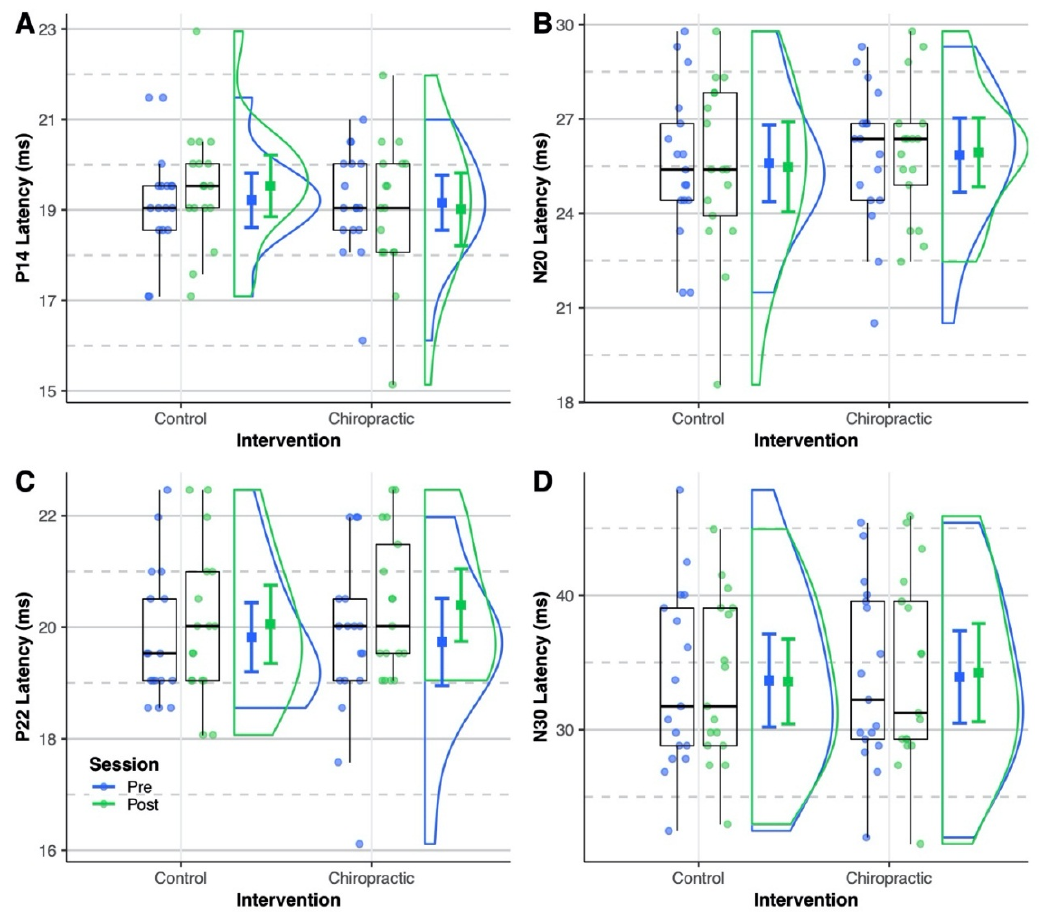
Figure 3. SEPs latency. Dots represent ( A ) P14, ( B ) N20, ( C ) P22, and ( D ) N30 latencies from all sessions of the analyzed subjects. Boxplots show the median, 25th and 75th percentiles. The error bars represent mean ± 95% CI. The distribution plots show the density distribution estimated by a Gaussian kernel with SD of 1.5. None of the SEPs latencies were significantly affected by either intervention.